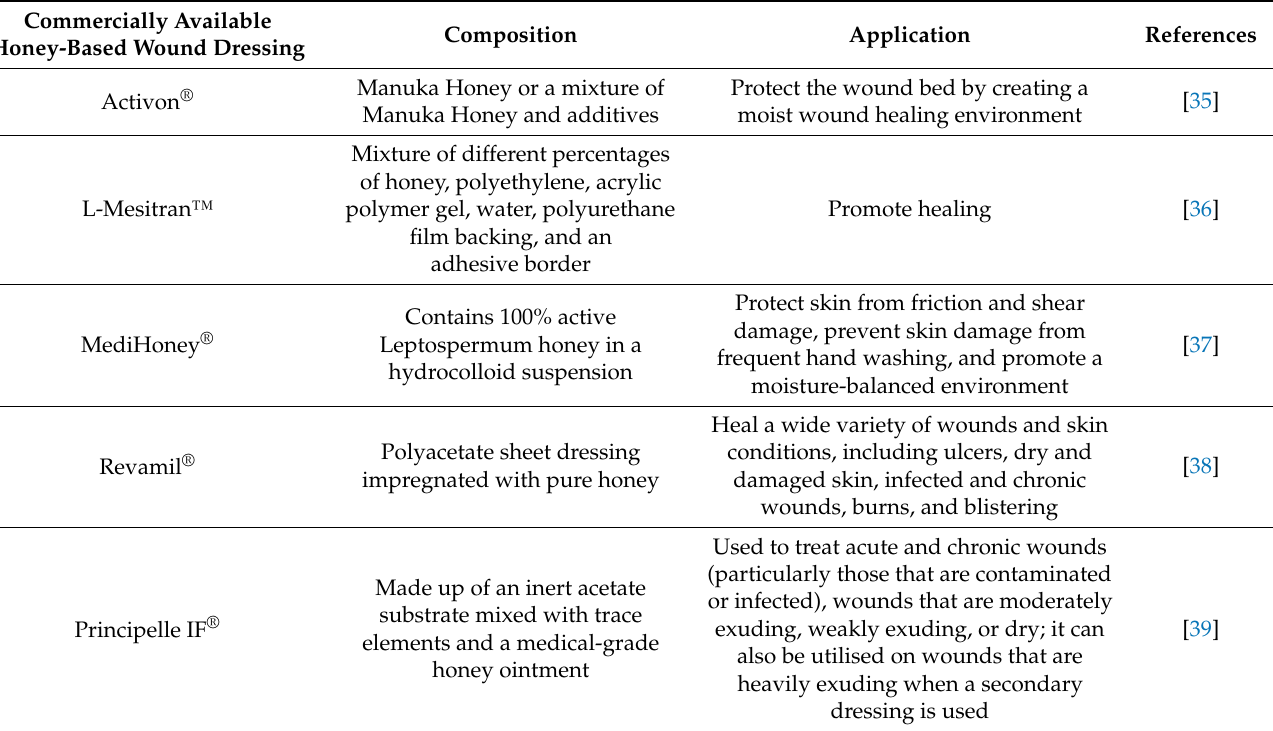
Table 2. Commercially available honey-based wound